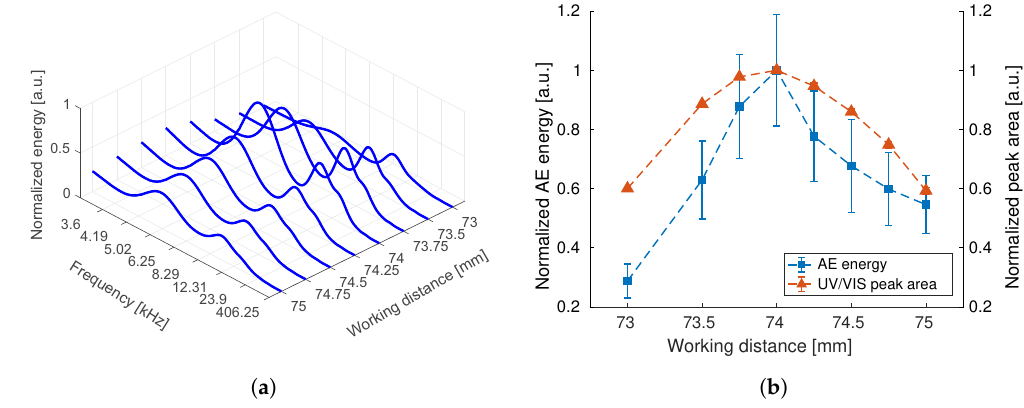
Figure 4. Results for PLAL at different working distances. ( a ) Frequency spectra of AE during ablation (average of 16 measurements); ( b ) Comparison of AE and